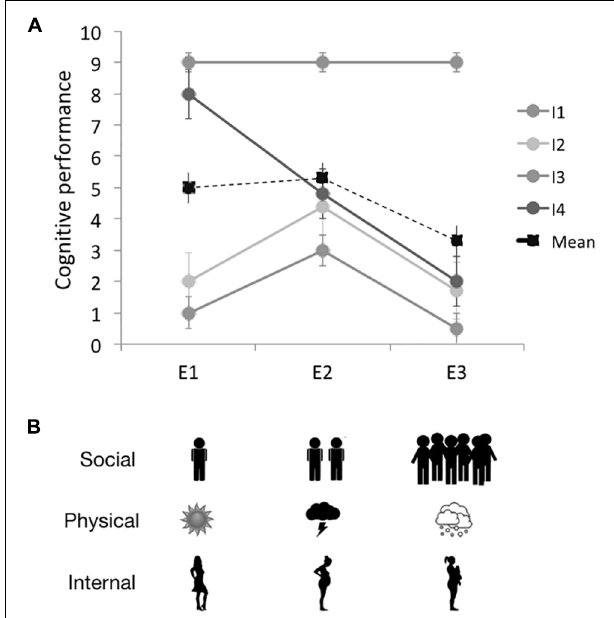
FIGURE 1 | Examples of reaction norms for plasticity in cognitive performance elicited by current environmental factors. (A) Cognitive performance from each of four individuals (I1–4) and the population response (Mean) as a function of three different environmental conditions (E1, E2, and E3). Vertical lines represent standard errors across trials on the same individual in the same environment and highlights the need for repeated measurements of cognition for each individual in each environment. If individuals are tested in E2 only, little variation in cognitive performances would be detected among individuals. If a different lab tests individuals in a similar, but not identical environment (e.g., E3), there would be a clear lack of correspondence in results contributing to the reproducibility crisis at both the individual and population levels. (B) Examples of environmental factors that might influence cognitive performance including social factors (e.g., number of observers/group size), physical factors (e.g., weather/season) and internal factors (i.e., reproductive status/hormonal